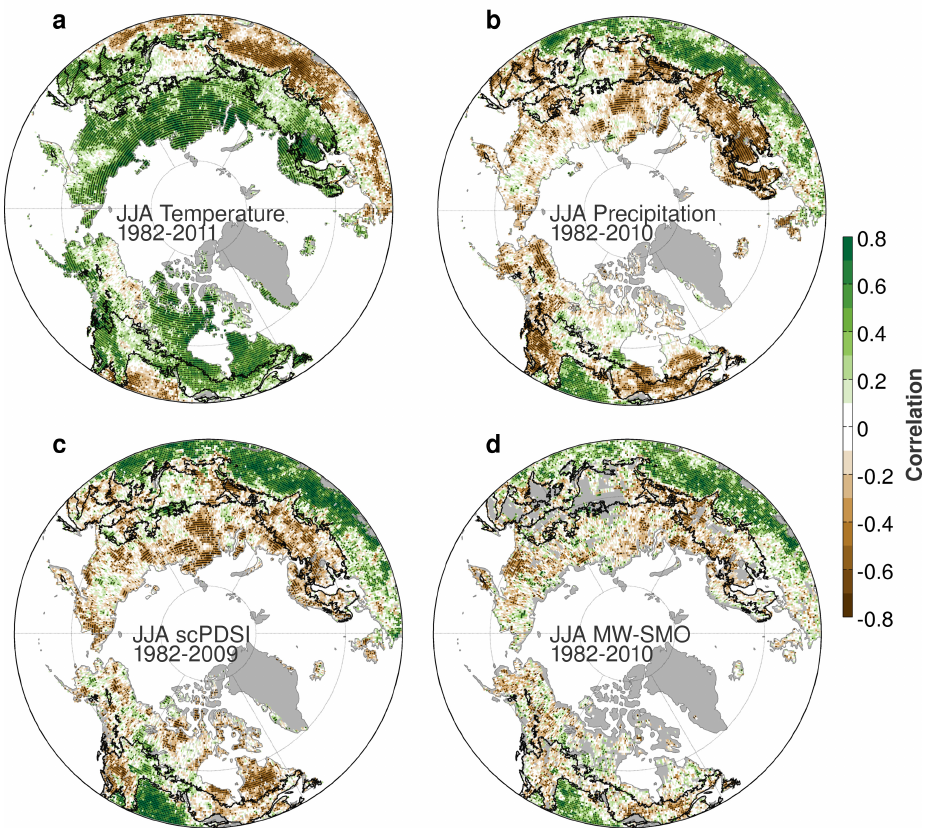
Figure 3. Correlation maps between summer NDVI and summer temperature, water supply and soil moisture variability since 1982. ( a ) Summer air temperature; ( b ) Summer precipitation; ( c ) Summer scPDSI; ( d ) Summer satellite microwave surface soil moisture (MW-SMO). All correlations are based on linearly detrended data and the stippling indicates statistically significant ( p < 0.1)